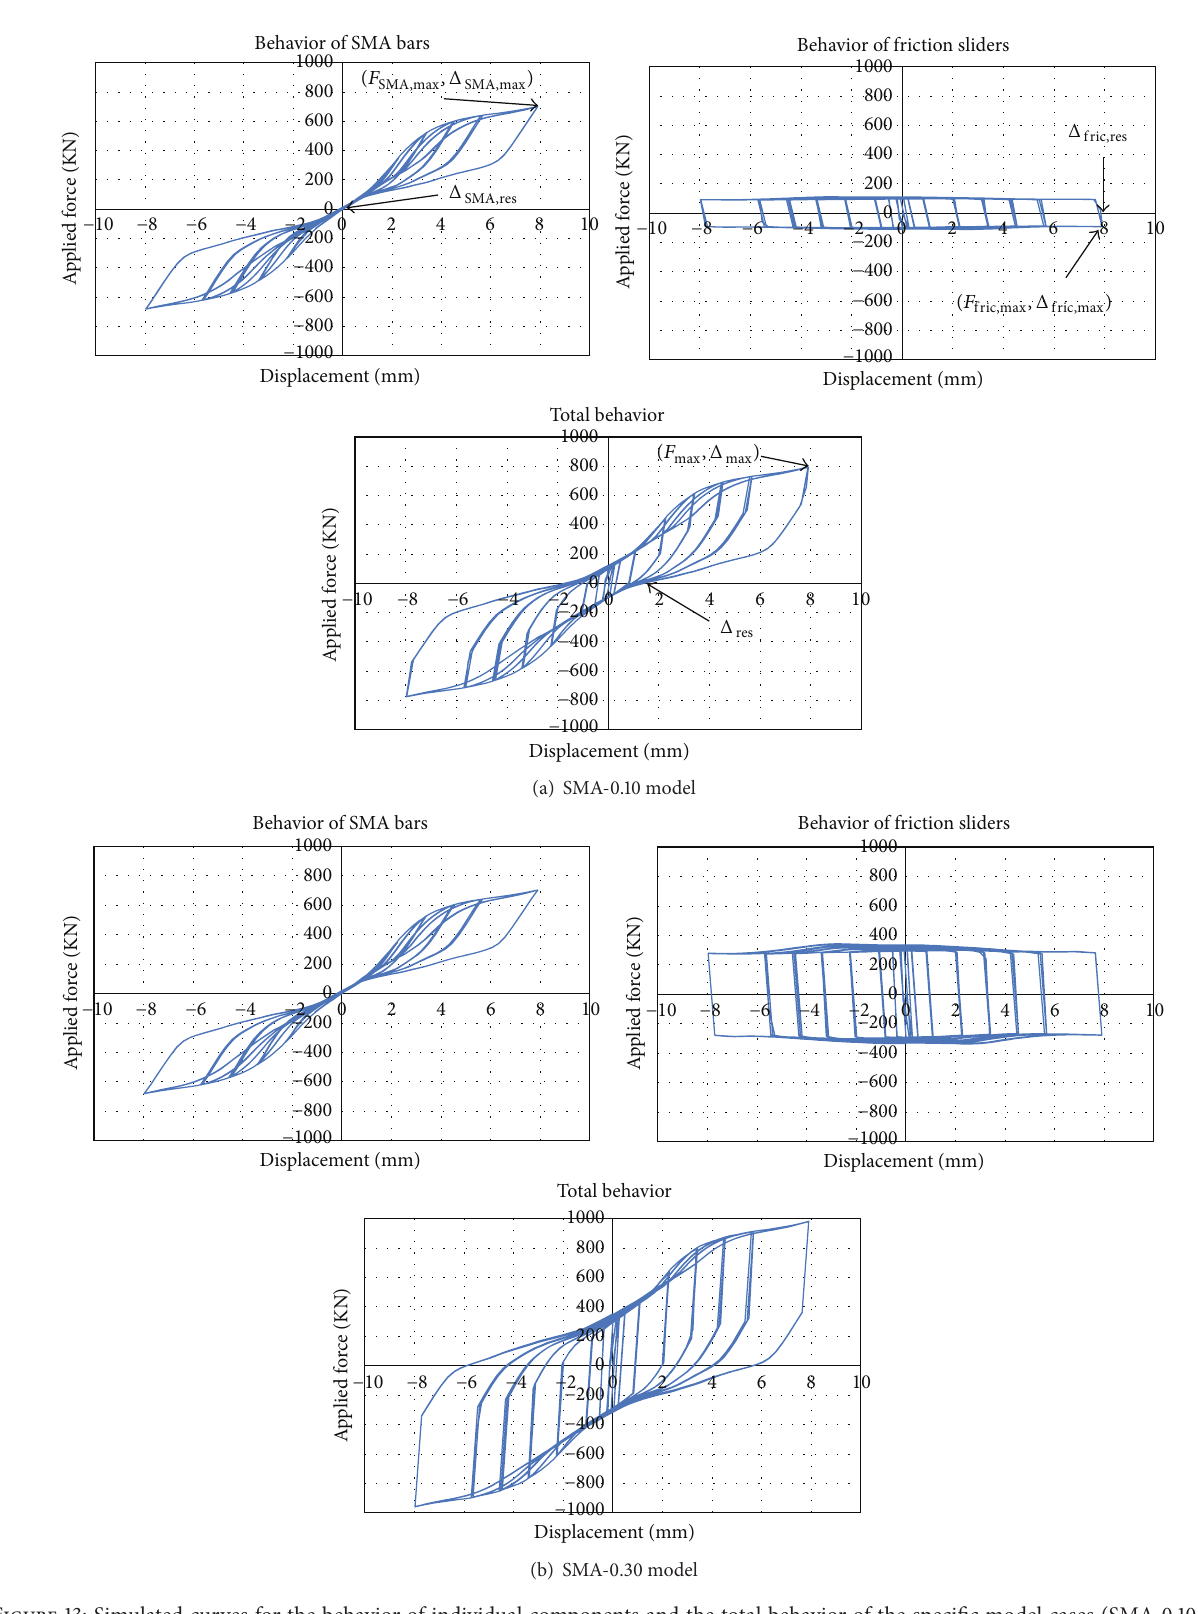
Figure 13: Simulated curves for the behavior of individual components and the total behavior of the specific model cases (SMA-0.10 and SMA-0.30